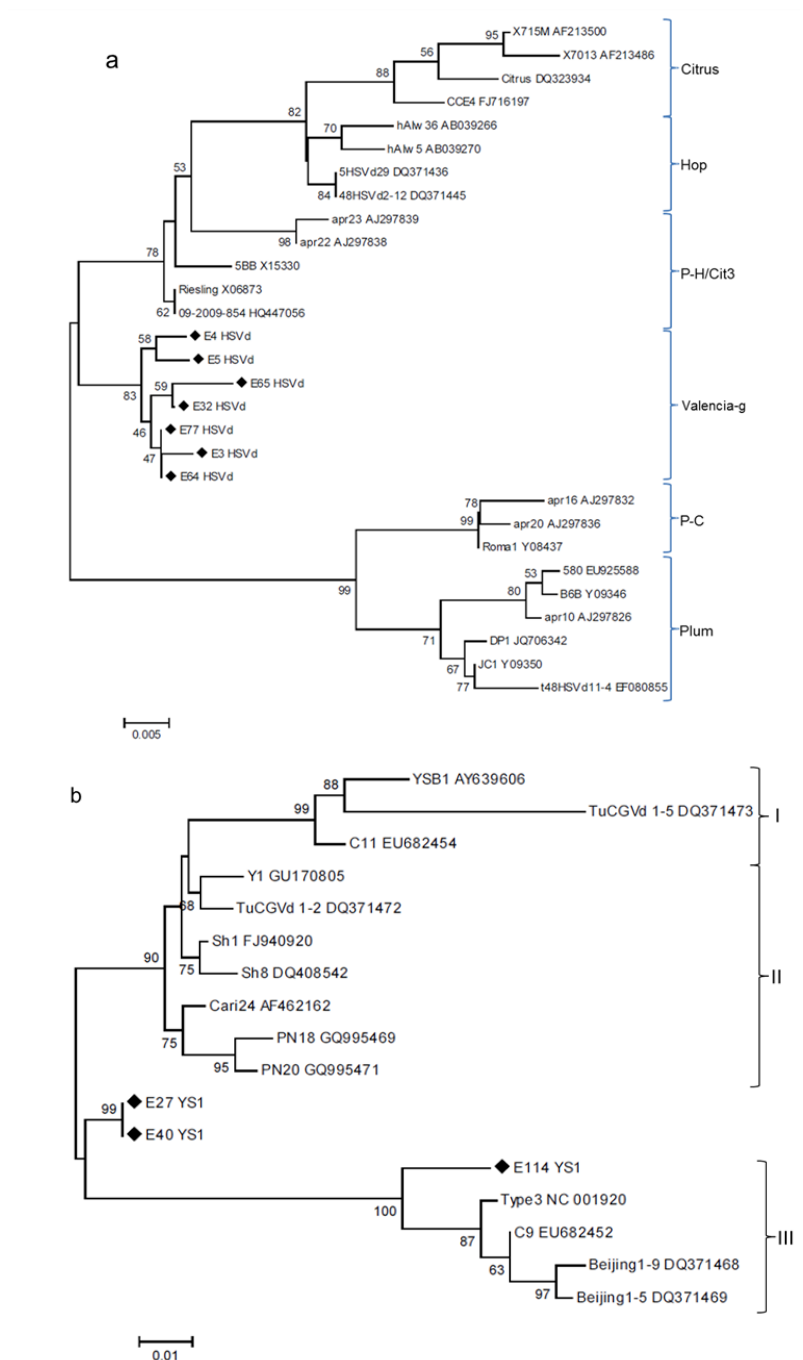
Figure 2. Neighbour-joining phylogenetic analysis of complete nucleotide sequences of viroid isolates. a: Phylogenetic analysis of HSVd Spanish isolates (300 bp); b: Phylogenetic analysis of GYSVd-1 Spanish isolates (367 bp). Numbers at nodes indicate bootstrap values of 1,000 replicates. Information about reference viroid isolates used to determine phyloge - netic relationships is achievable by the corresponding accession number for GYSVd-1, and by Amari et al. , 2001 for HSVd. Spanish isolates sequenced for this study are marked with ♦ and GenBank accession numbers are listed in Table